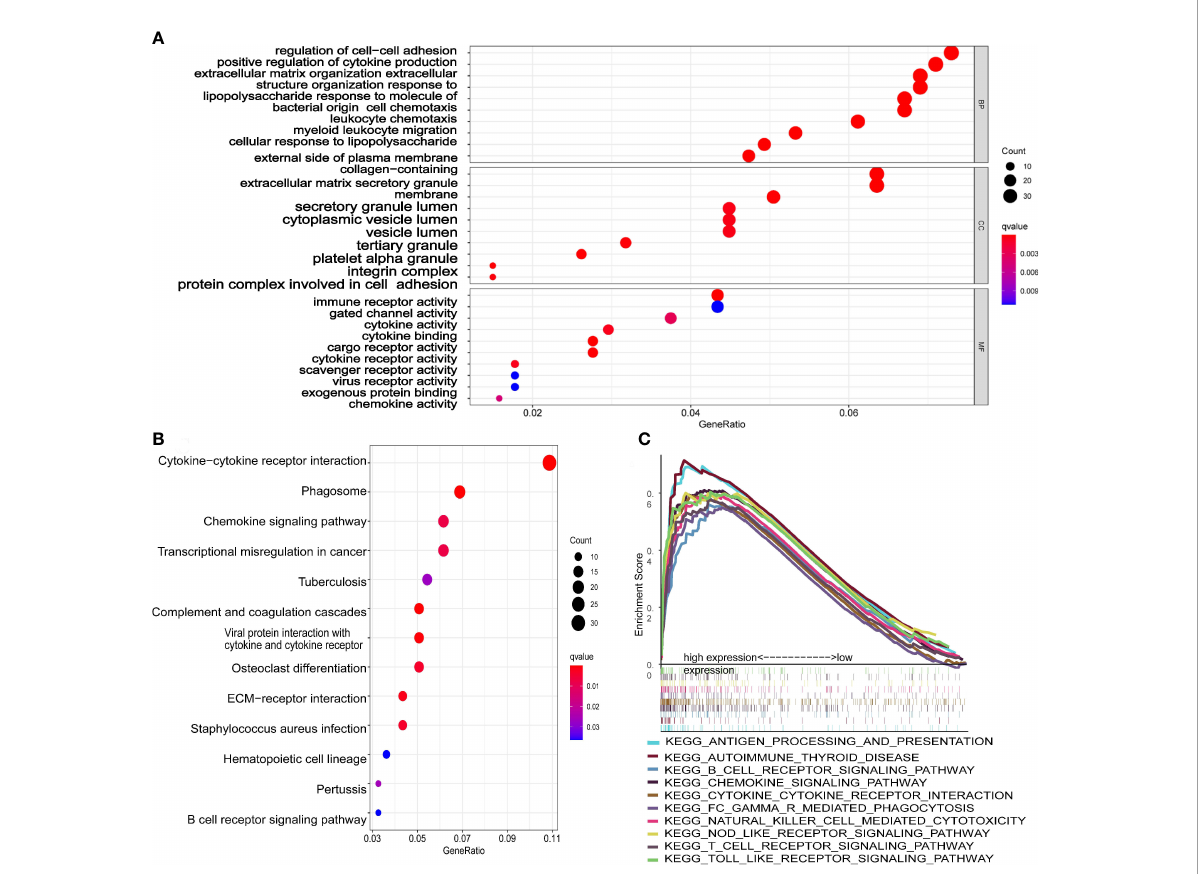
algorithm. 8 types of immune-related cells (naive B